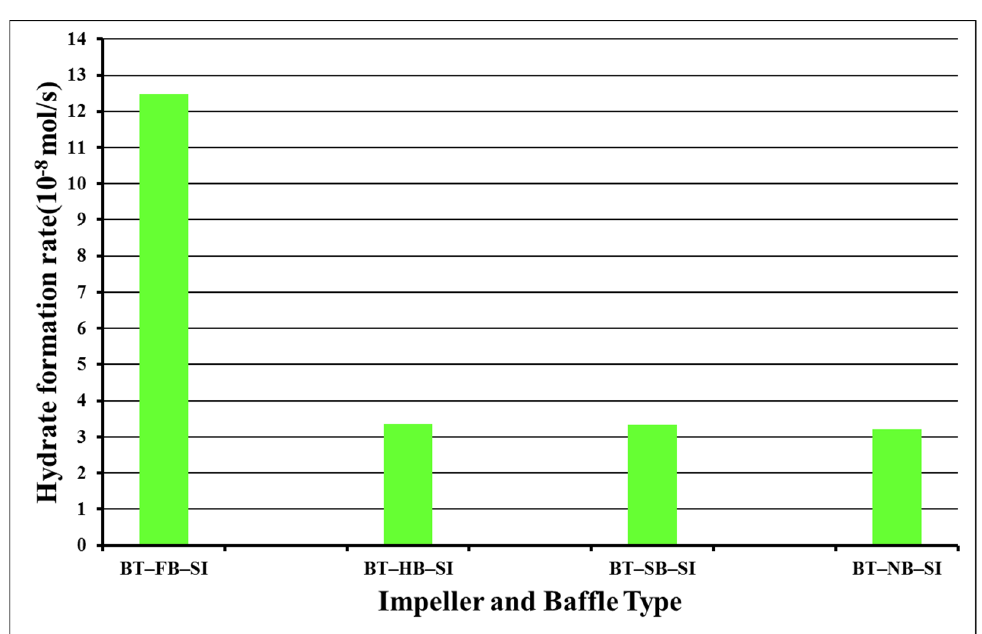
Molecules 2022 , 27 , x FOR PEER REVIEW Figure 8. Hydrate formation rate constant in single ‐ impeller experiments. Figure 8. Hydrate formation rate constant in single-impeller experiments.